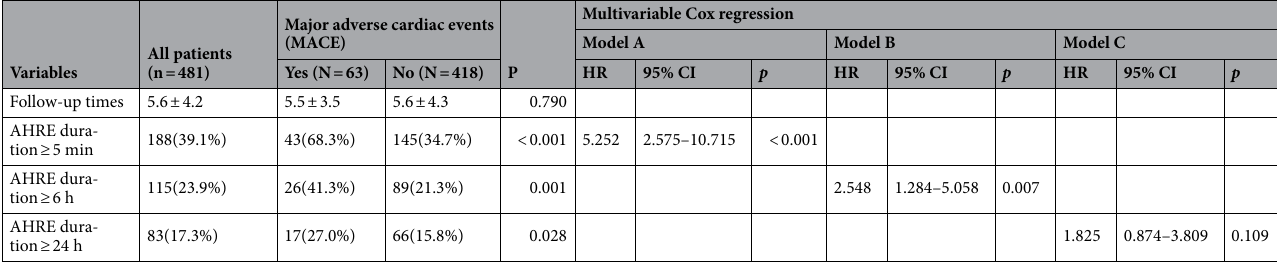
Table 3. Cox proportional hazard regression analysis with time-dependent covariates for MACE predictors in patients with AHREs ≥ 5 min (Model A), ≥ 6 h (Model B), ≥ 24 h (Model C). Data are presented as mean ± SD or median, IQR or n (%). AF atrial fibrillation, AHRE atrial high-rate episodes, BMI body mass index, EF ejection fraction, IQR interquartile range, LA left atrium, LVEF left ventricular ejection fraction,